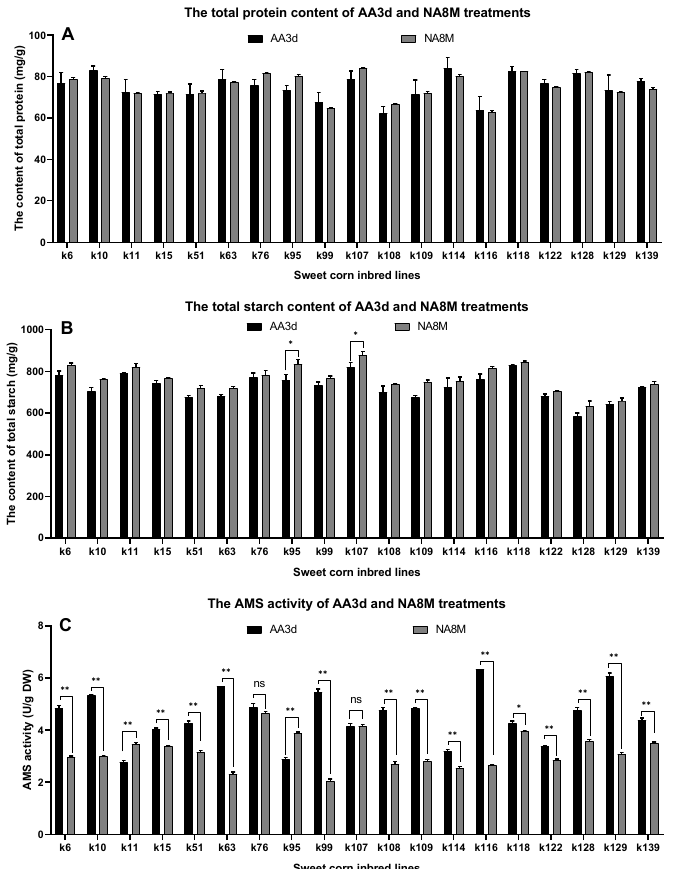
Figure 3. Comparative analysis of total protein content, total starch content and amylase activity in AA3d- and NA8M-treated seed from 19 sweet corn lines. ( A ) Total protein content of AA3d- and NA8M-treated seeds. ( B ) Total starch content of AA3d- and NA8M-treated seeds. ( C ) Amylase activity of AA3d- and NA8M-treated seeds. No label indicates no significant difference between AA3d and NA6M in A and B. ‘ns’, * and ** indicate p > 0.05, p ≤ 0.05 and p ≤ 0.01, respectively.